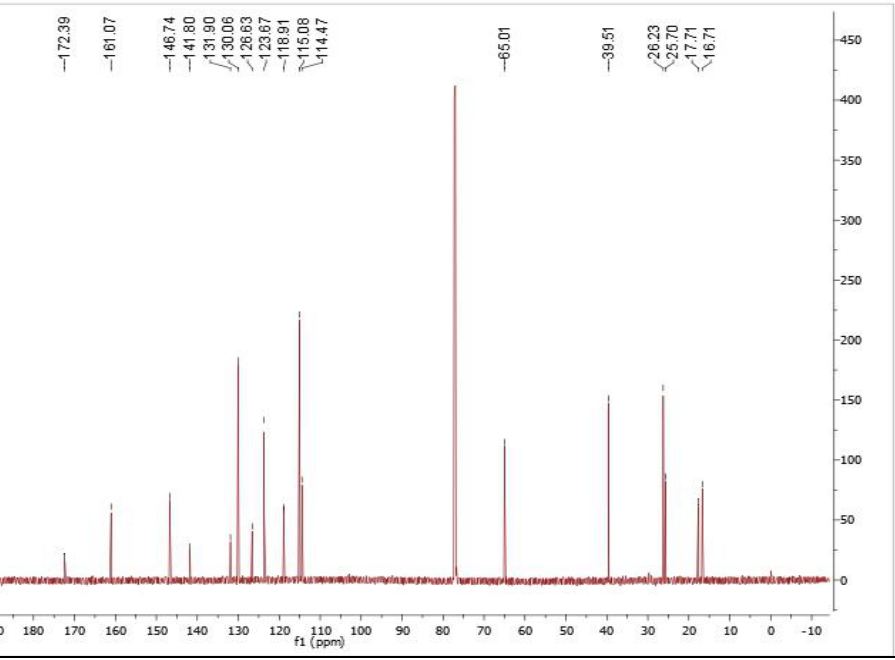
Figure 2. 13 C NMR spectrum of 7-geranyloxycinnamic acid.